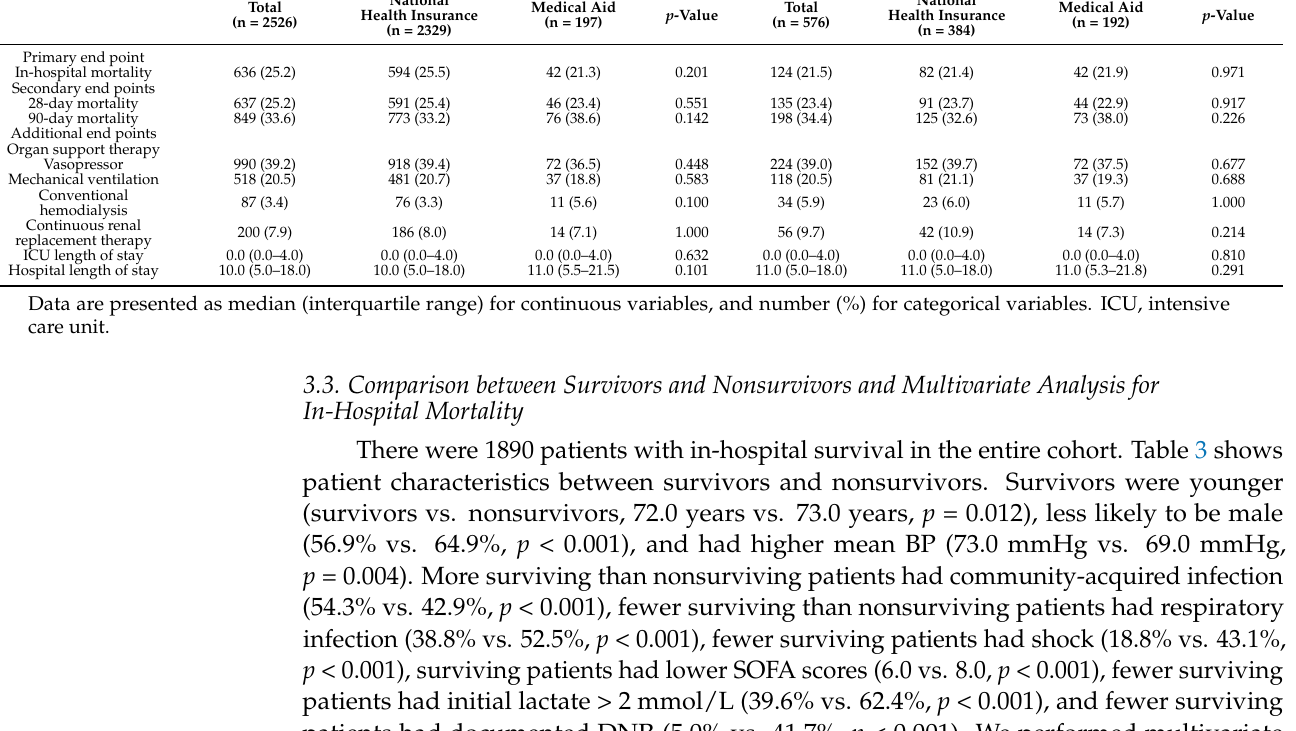
Figure 2. Comparison of NHI versus MA in various variables. The MA group had fewer males (NHI vs. MA, 59.7% vs. 50.3%, p = 0.009), more chronic kidney disease (7.7% vs. 12.2%, p = 0.027), more multiple sources of infection (1.8% vs. 5.1%, p = 0.010), and more patients with initial lactate >2 mmol/L (44.1% vs. 59.9%, p < 0.001). NHI, National Health Insurance; MA, Medical Aid; DNR, do-not-resuscitate; AMA, against medical advice; MV, mechanical ventilation; HD, hemodialysis; CRRT, continuous renal replacement therapy; CI, confidence interval. Table 2. Patient outcomes of the full study cohort and propensity-matched cohort. FullStudyCohort